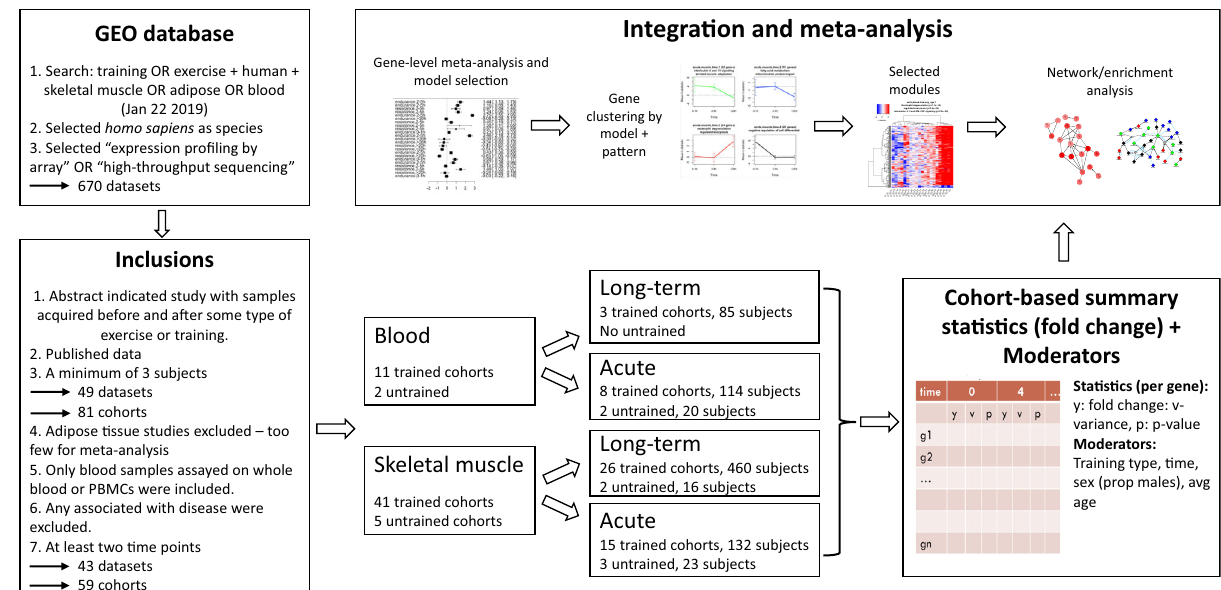
Fig. 1 Study overview. We started with a search in the Gene Expression Omnibus. Manual examination of the studies and a set of fi lters resulted in 43 studies that had whole-genome expression pro fi les from blood and muscle. The data covered 59 exercise cohorts that were partitioned into four types of meta-analysis (i.e., by tissue and exercise modality). Seven-hundred and thirty-nine subjects were included in total, where some are represented in several cohorts, for example when sampling was made in association to both acute exercise and long-term training.